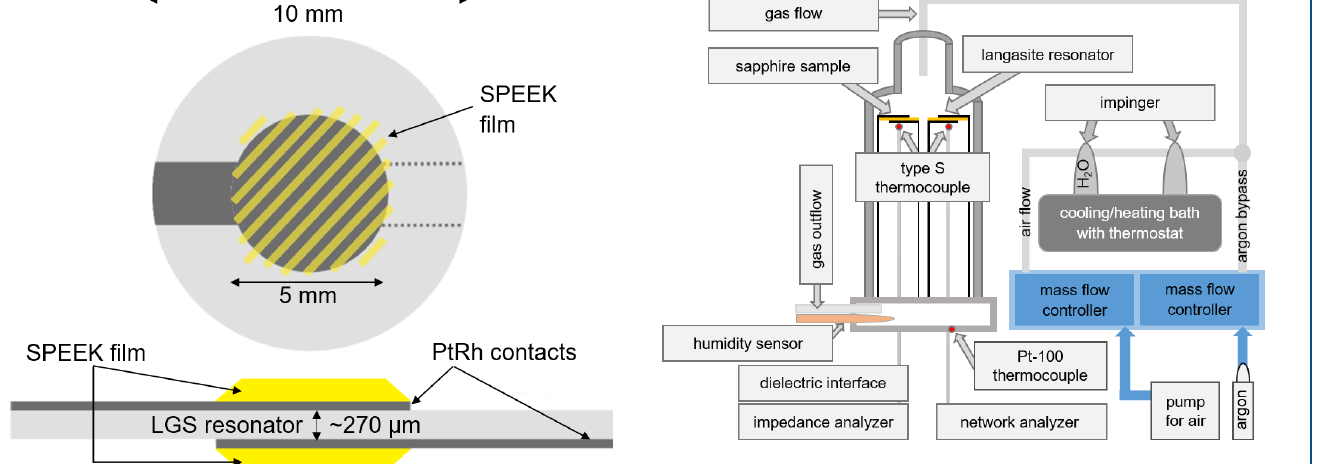
Figure 4. Scheme of the experimental